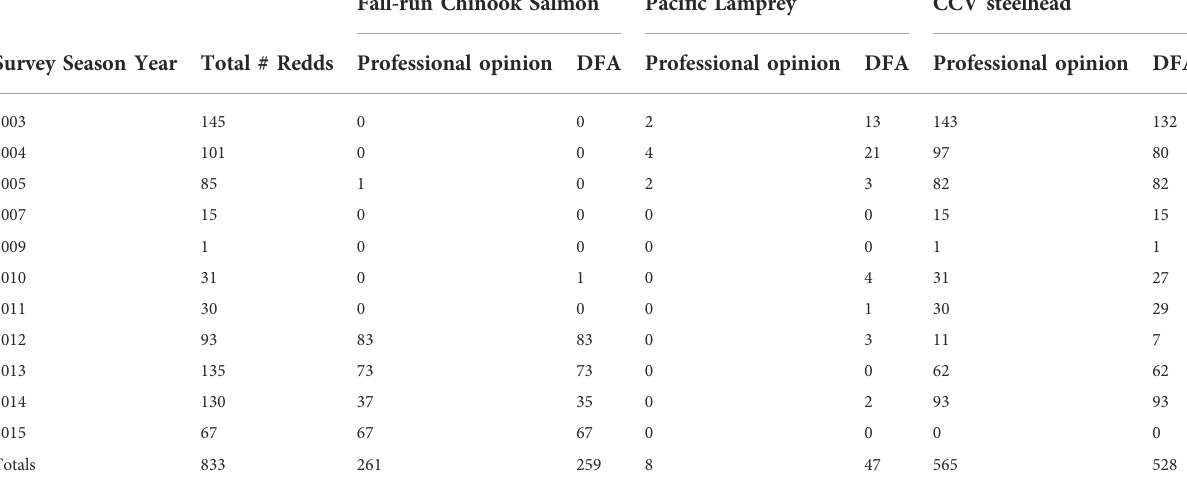
TABLE 4 Comparison between redd identi fi cation based on professional opinion versus the discriminant function